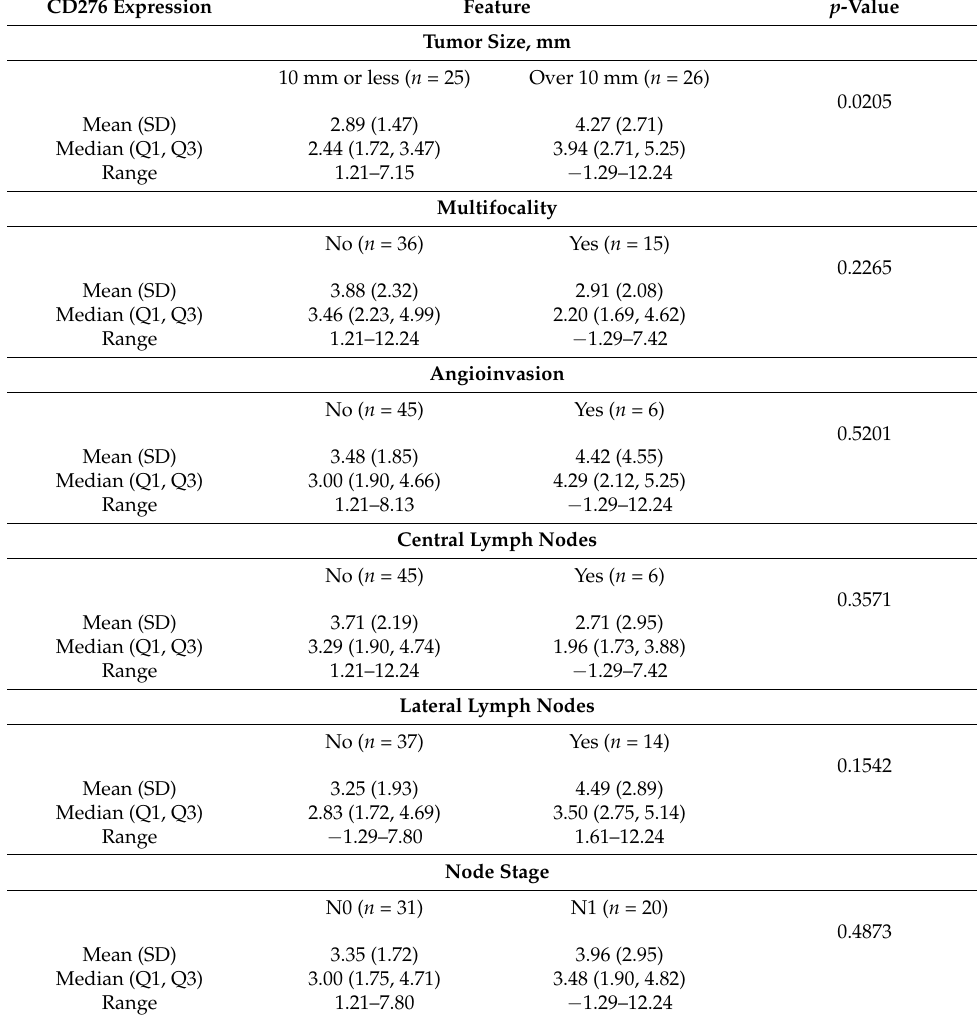
Figure 2. Relationship between CD276 expression by tumor cells and tumor size, mm ( a ); range of tumor diameter ( b ). Table 3. Relationship between CD276 expression and histopathological and clinical factors.